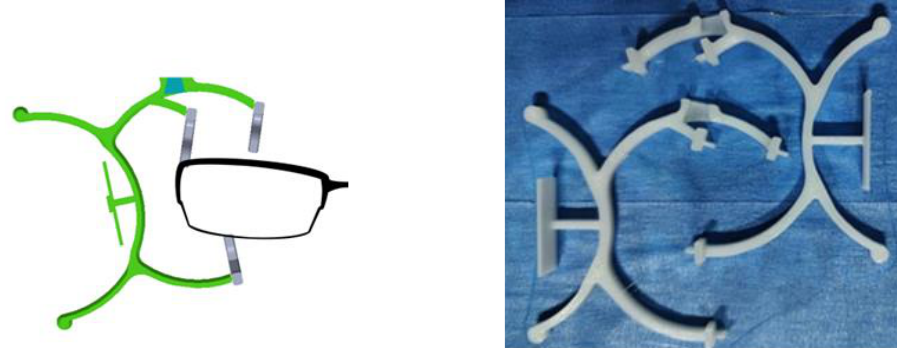
Figure 7. Principle of operation and PLA manufactured compliant